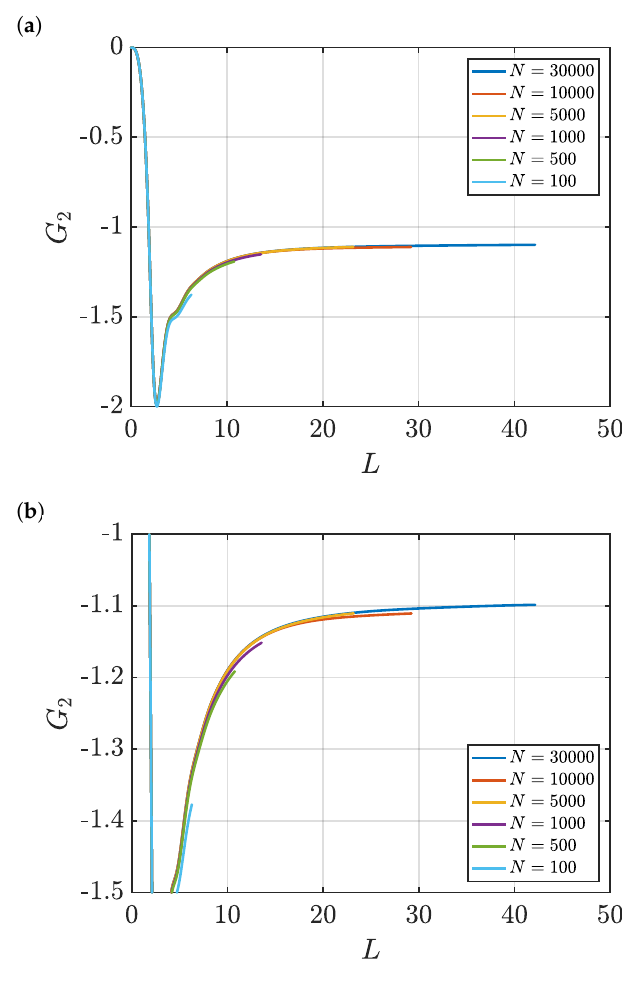
Figure 7. ( a ) Estimation of KB integrals in the thermodynamic limit, G 2 (Equations (6) and (7)) vs. L for the LJ fluid at T = 2 and ρ = 0.4 (dimensionless units). The values of G 2 are computed for systems with varying number of molecules N . The used RDFs are provided in Figure 5. ( b ) A zoom in of the plots in Figure ( a ) is shown.